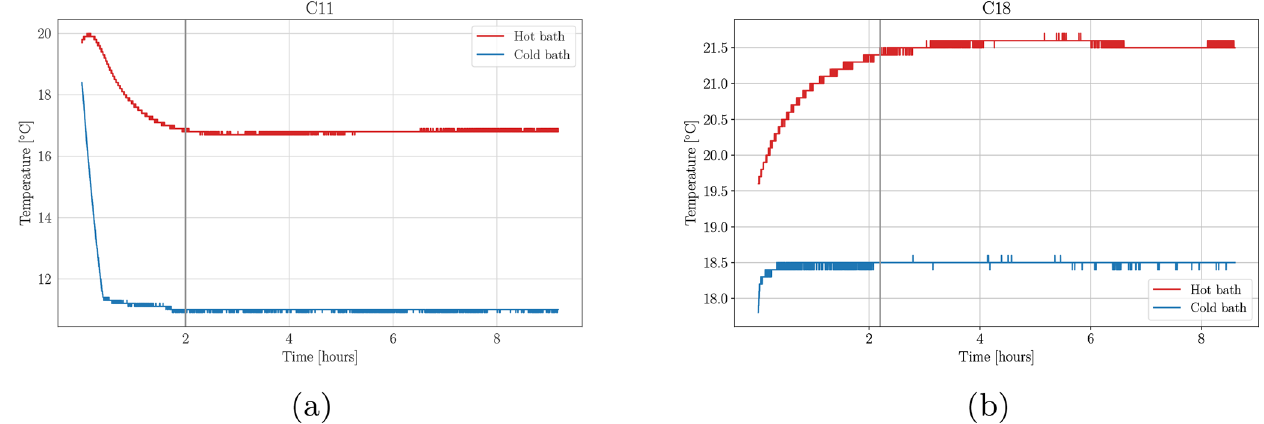
Figure A1. Time series of the temperatures measured in the outer (red) and inner (blue) rings for the experiments C11 (a) and C18 (b) . The vertical grey line marks when the tank is set into